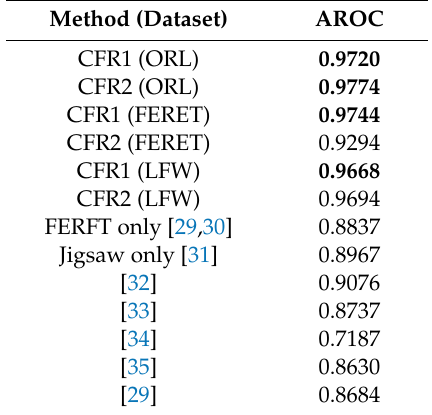
Table 4. Comparison of AROC between proposed schemes and state-of-the-art cancellable